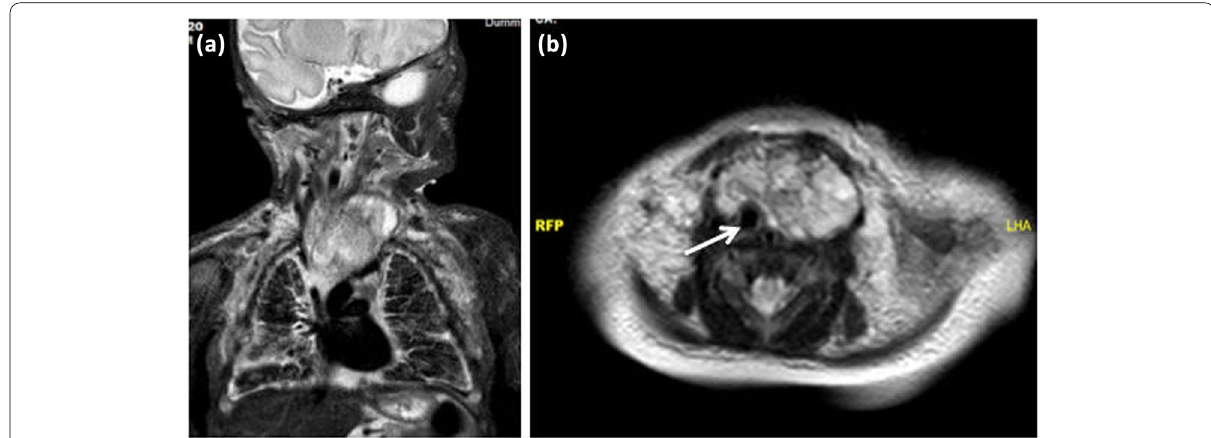
Fig. 1 a A solid mass with small cystic and necrotic areas and enhancing is observed in coronal fat-suppressed T2-weighted image. b In the axial T2-weighted image, the lesion pushes the trachea (arrow) to the